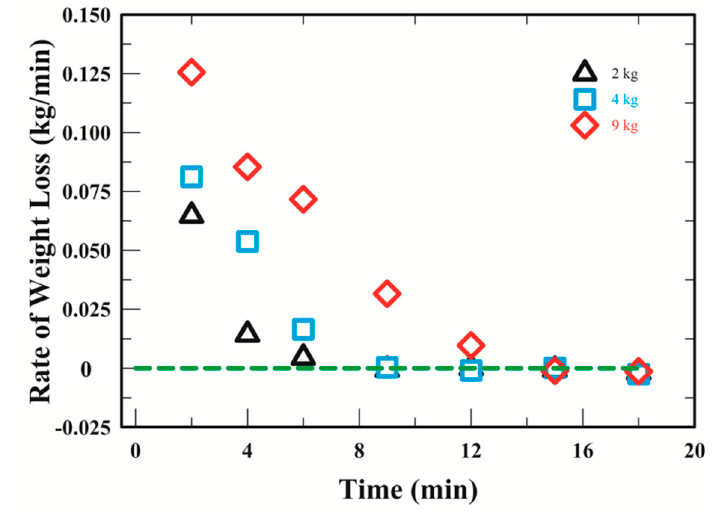
Figure 3. Effect of WG loading on the weight loss in a drying procedure of wheat germ by different loadings from 2 to 9 kg at 120 °C. with backward differencing from the data of the moisture content.